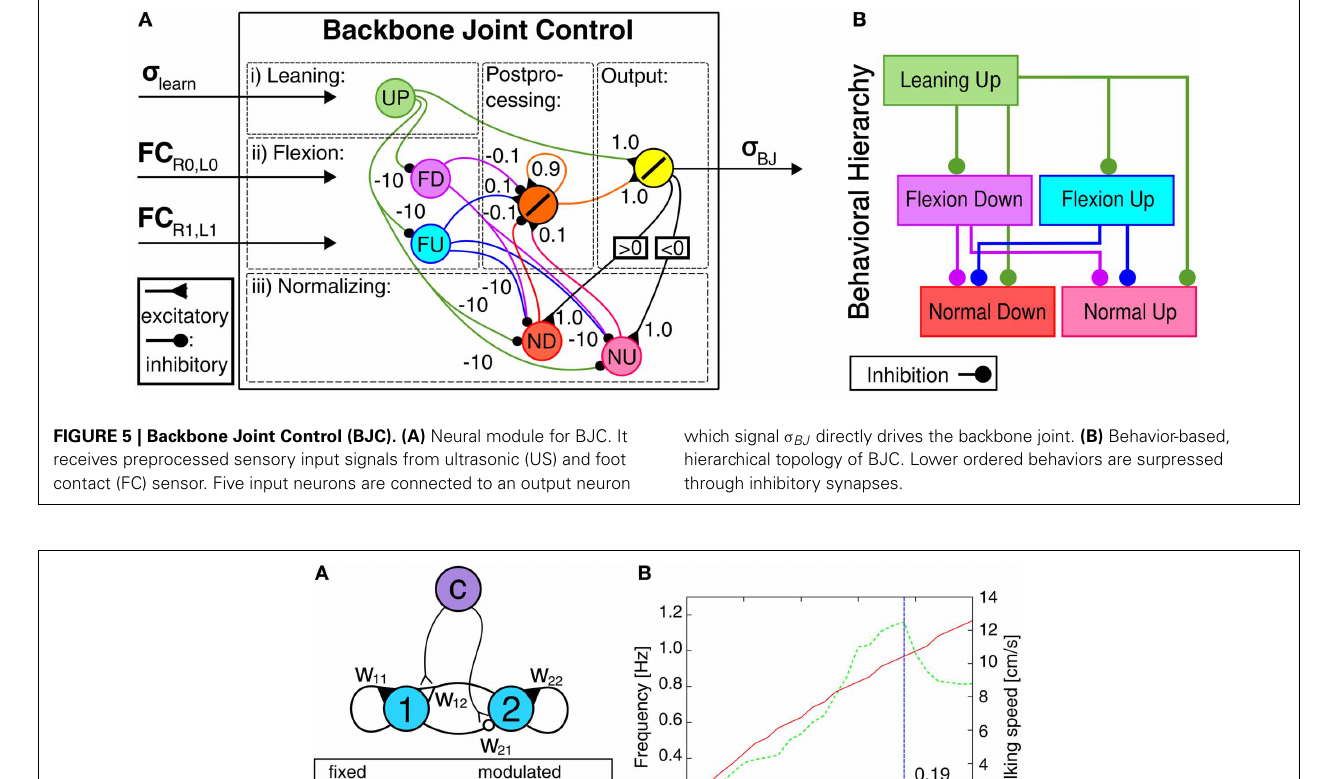
FIGURE 6 | Neuromodulated CPG mechanism. (A) CPG circuit diagram for periodic pattern generation. The synaptic weights w 12 and w 21 are modulated by an extrinsic control input c , i.e., w 12 = 0 . 18 + c = − w 21 . The fixed synaptic weight are set to